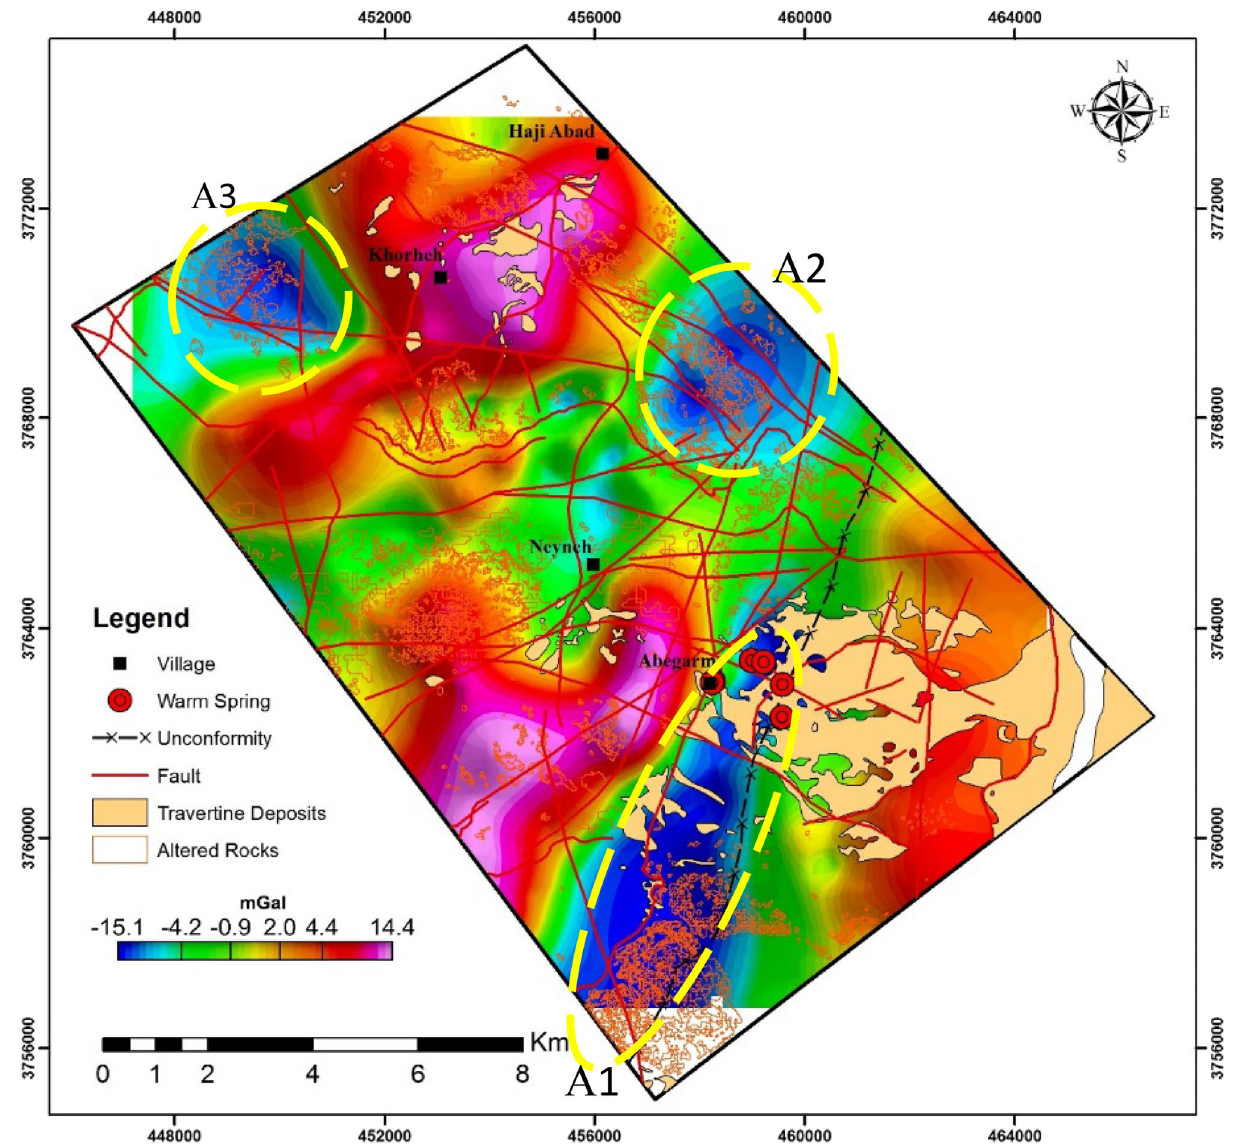
Figure 7. Residual gravity anomaly map of Mahallat Region a surface manifestation of geothermal resources including warm springs, travertine deposits and altered rocks (figure exported from GEOSOFT Oasis montaj 9.2 available in https:// www. seequ ent. com).